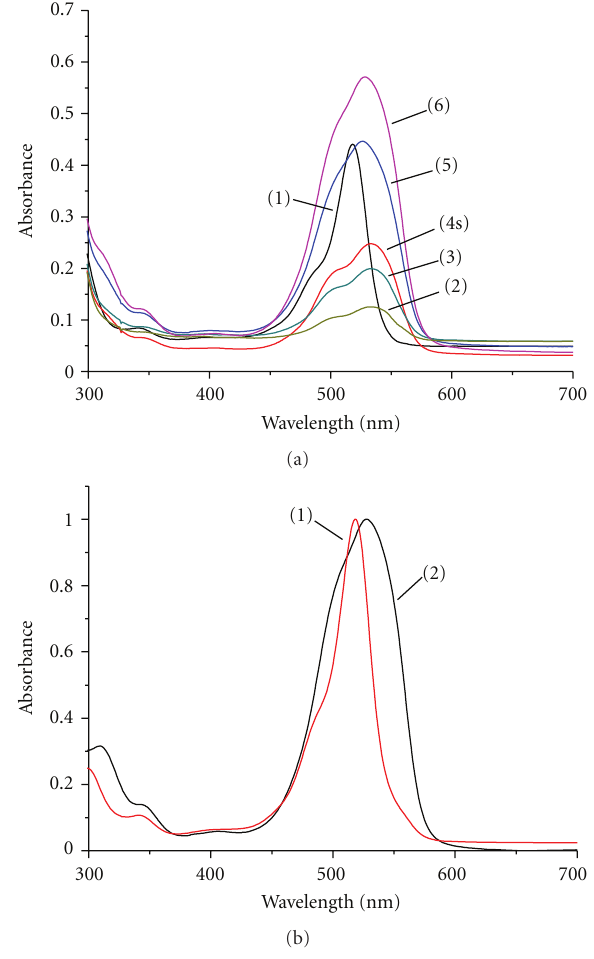
Figure 2: Experimental absorbance spectra of Eosin Y without (1) and with (2–6) the presence of surrogate alcoholcontainingPHMG; c (Eosin) in mg/L: 0.82 (2); 1.63 (3); 3.26 (1, 4); 6.52 (5); 8.16 (6) (a); Resolved MILCA spectra of Eosin Y (1) and PHMG - Eosin Y complex (2)